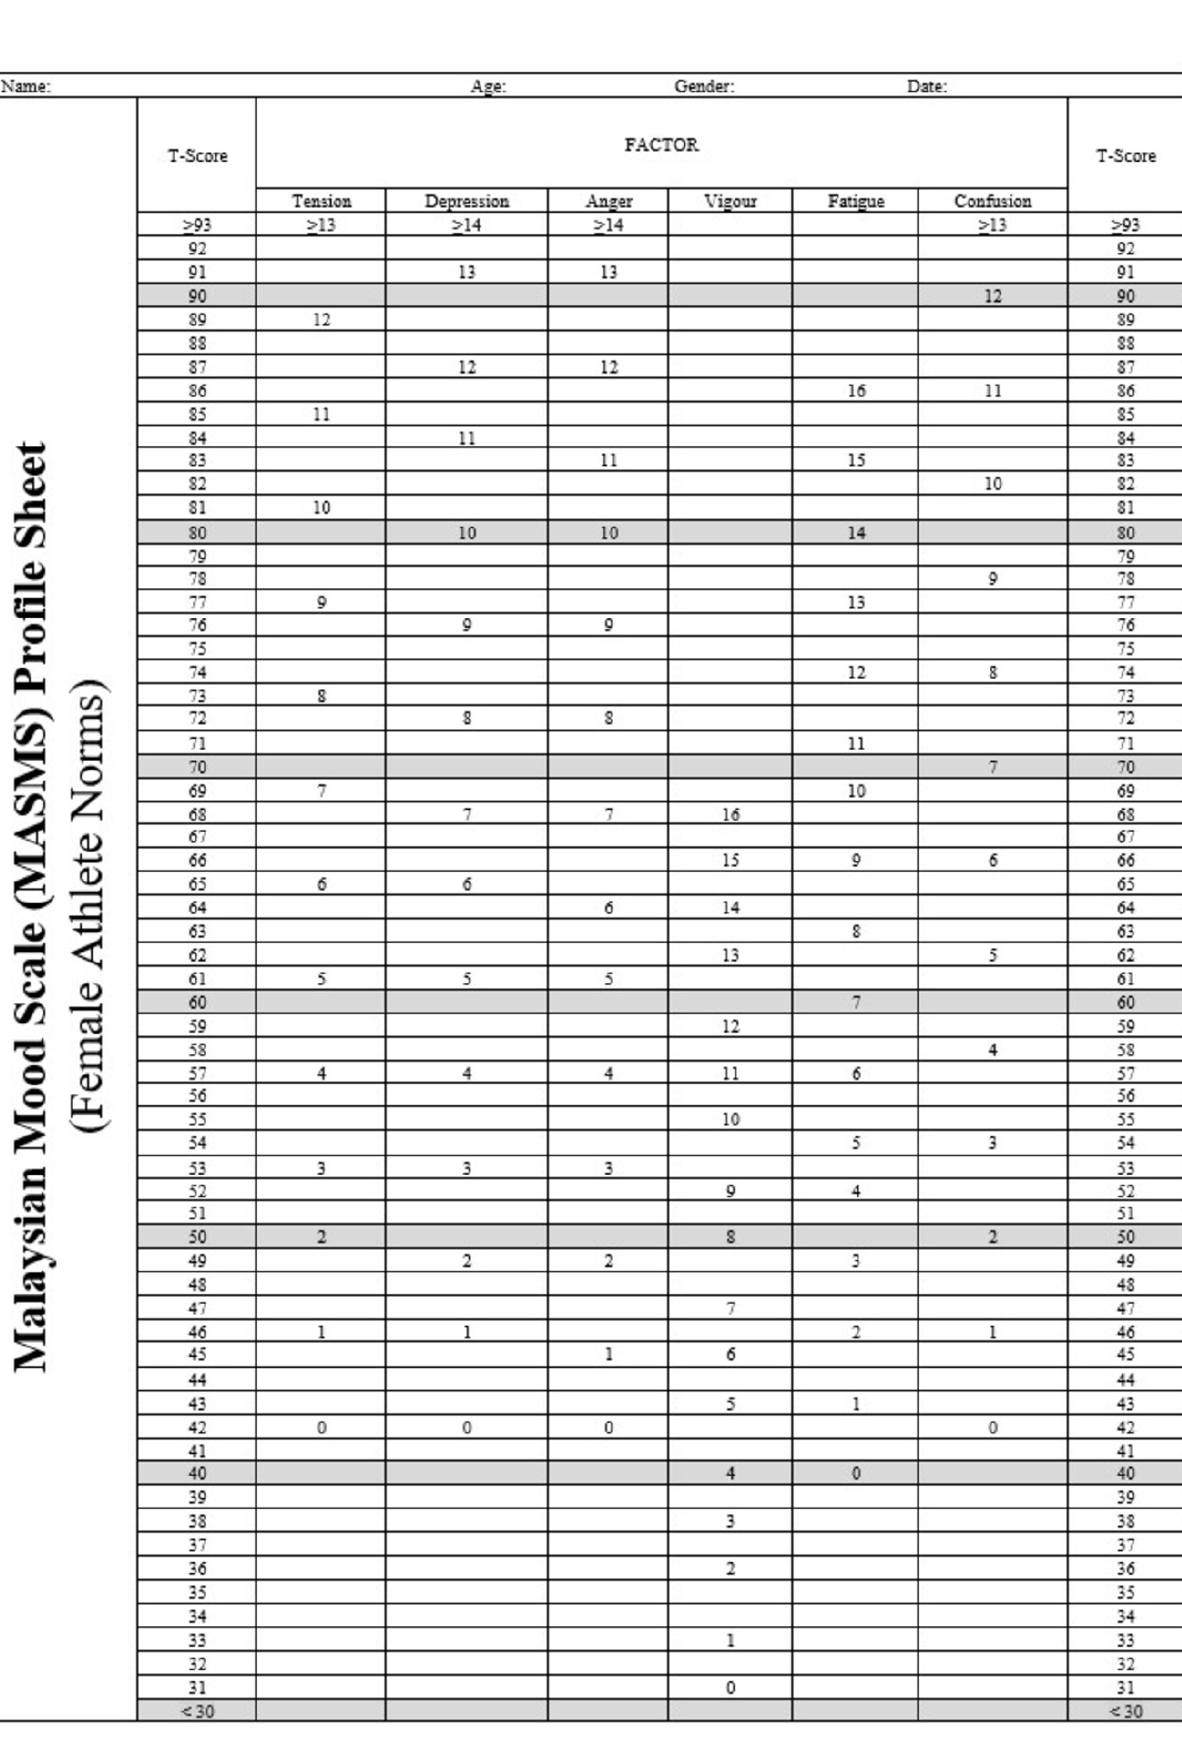
Figure A3. MASMS profile sheet (female athlete norms).